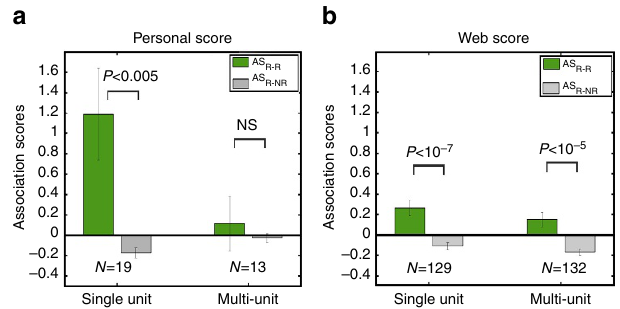
Figure 3 | Mean association values with personal and web-based scores. ( a ) Mean association score for the pairs of pictures to which the neuron fired (AS R-R ; green) and for the other pictures pairs (AS R-NR ; grey) based on the patients’ scores. ( b ) Same as a but considering a larger set of responses using the web-based association